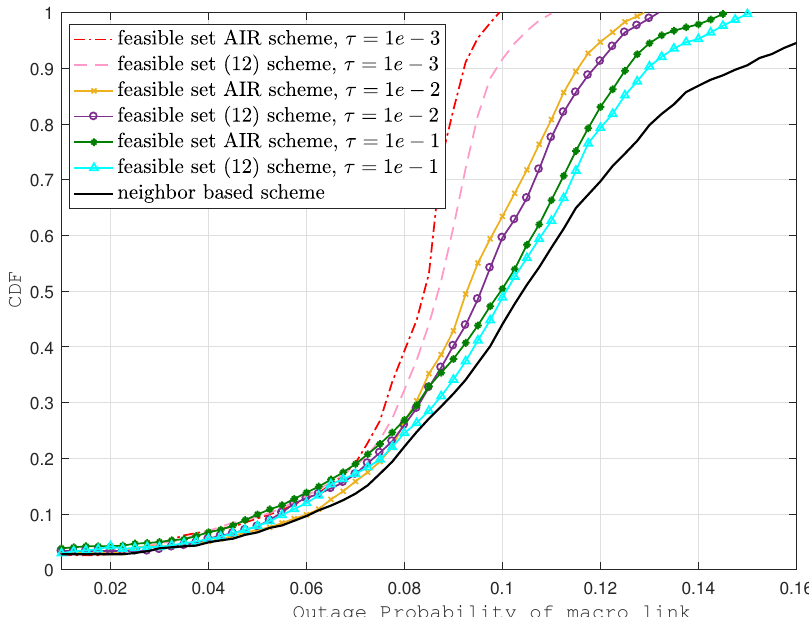
Figure 4. Outage probability of macro-links with various